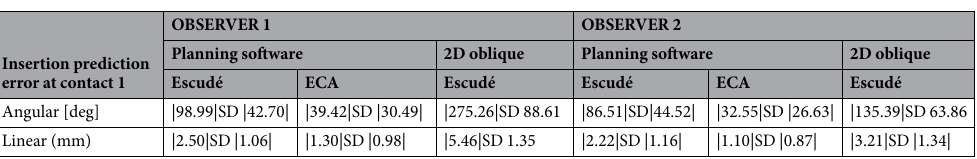
Table 1. Absolute angular and linear insertion depth prediction errors for the Escudé approach and ECA for both observers. Accuracy of the predicted angular (DEG) and linear (mm) insertion depth errors for both the planning software (using Escudé approach and ECA) and for the traditional estimation based upon a 2D oblique view. Preoperative predicted values were subtracted from the postoperative actual insertion depth values. Mean errors and their standard deviation (SD) of the absolute values are